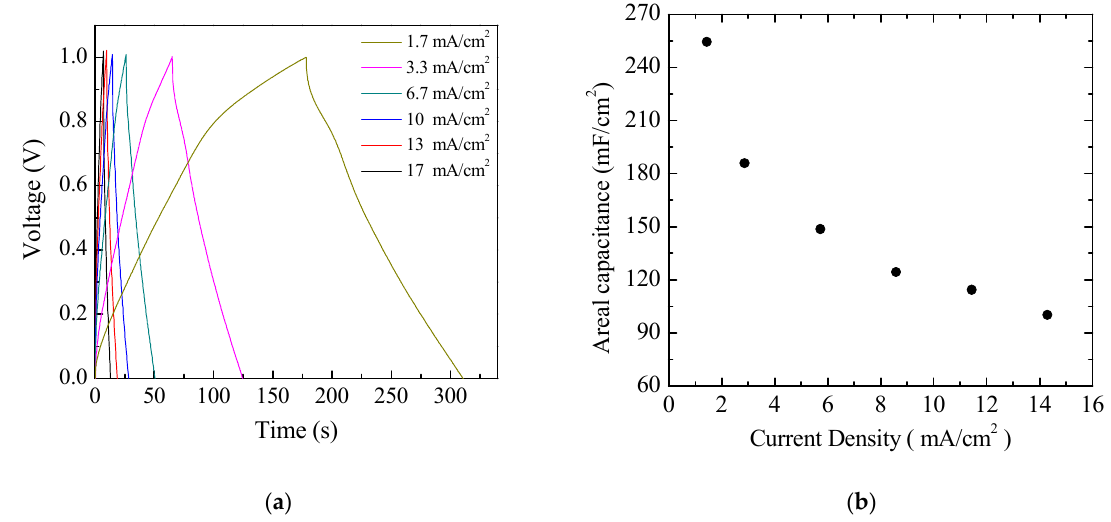
Figure 13. ( a ) Voltage versus time measured in charging–discharging cycles at constant density on the same Au/PPy- GNP:DBSA/Nafion:LiPs/PPy-GNP:DBSA/Au cells that Figures 11 and 12 refer to; ( b ) areal capacitance estimated from the charge–discharge curves from ( a ) as a function of the current density.